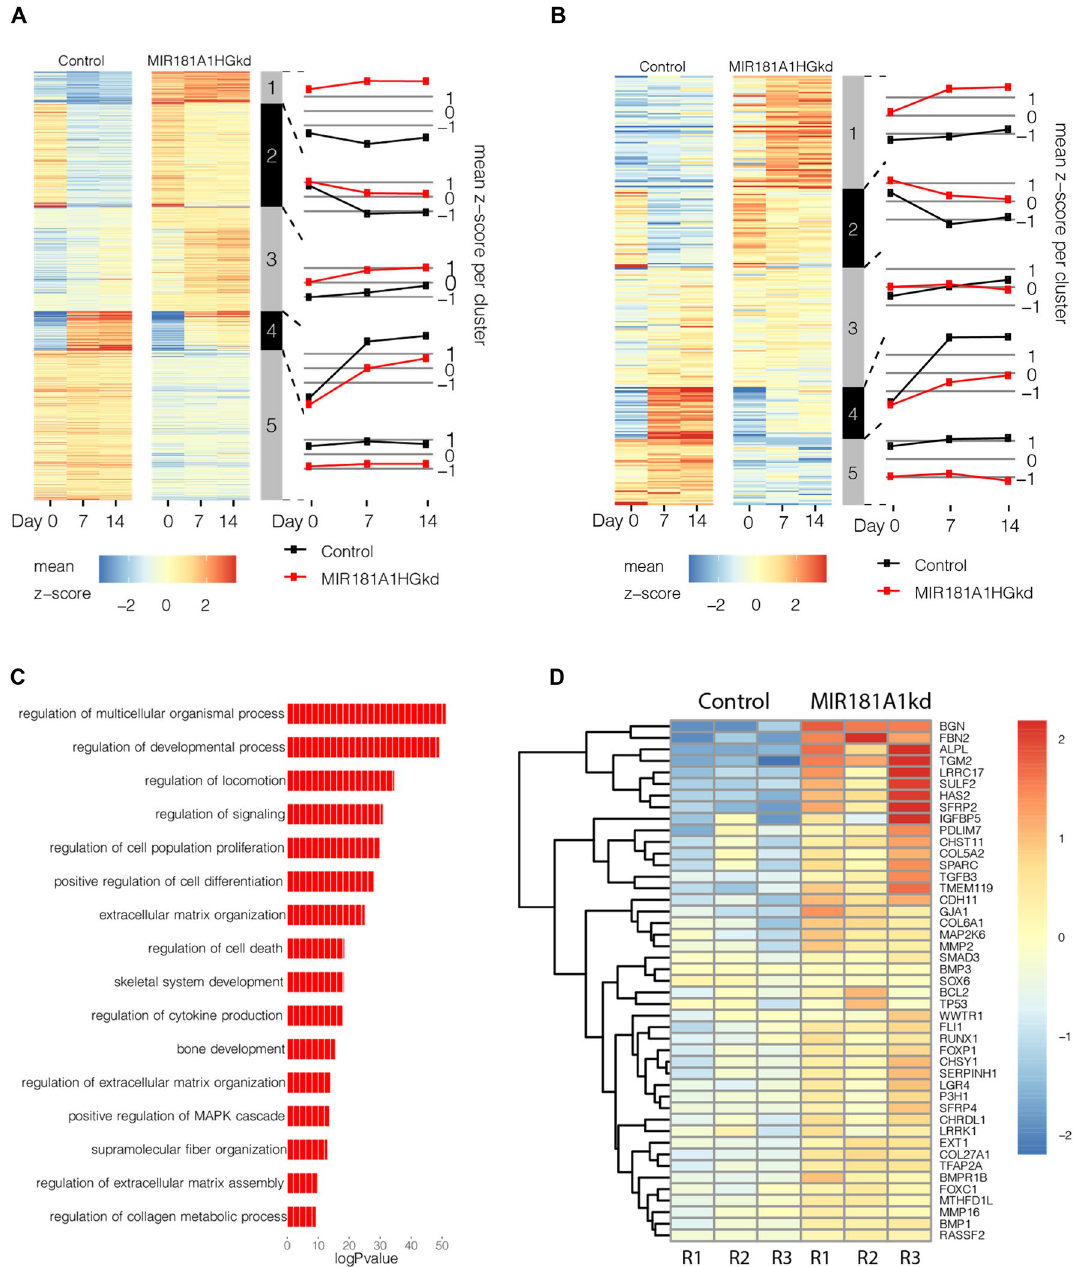
Figure 6. MIR181A1HG knockdown causes an increase in extracellular matrix gene expression. ( A ) Expression profile of 1580 DE mRNAs in CRISPRi modified hMSC-hTERT20 cells (red) compared to CRISPRi control cells (black) (n = 3). ( B ) Expression profile of 267 DE lncRNAs in the same MIR181A1HGkd and control cells. ( C ) Gene Ontology of mRNAs with increased expression after MIR181A1HGkd at Day 7. ( D ) Upregulated genes at day7 associated with skeletal and bone development. ( E ) Upregulated genes at day7 associated with extracellular matrix organization. ( F ) Upregulated genes at commitment associated with collagen and supramolecular fiber organization. ( G ) Gene Ontology of mRNAs decreased expression after MIR181A1HGkd Day7. ( H ) Gene Ontology of downregulated genes at commitment associated with limb and appendage development. ( I ) Gene Ontology of downregulated genes at commitment associated with WNT